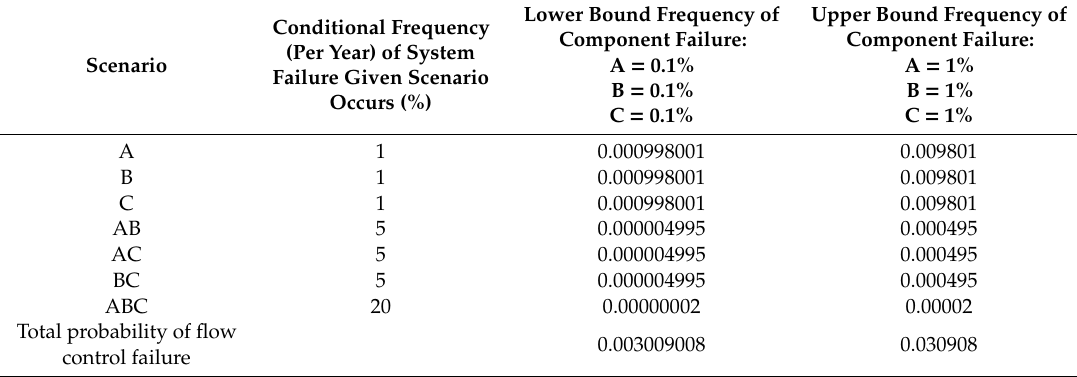
Table 2. Probabilistic risk assessment using example Deterministic Monte Carlo simulation